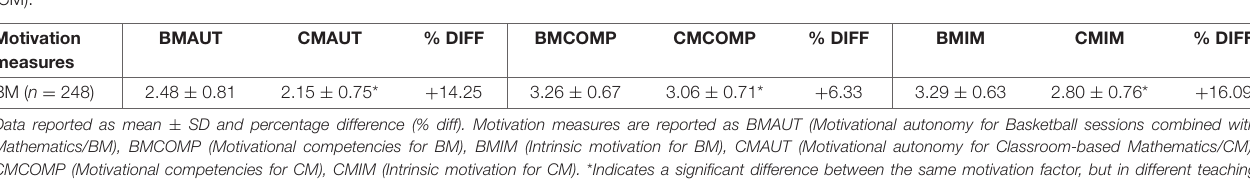
that BM had a more positive influence on children’s intrinsic motivation for classroom-based mathematics compared to CON. No differences were seen between the intervention and control groups in changes in any of the extrinsic types of motivation for mathematics, where both groups showed insignificant